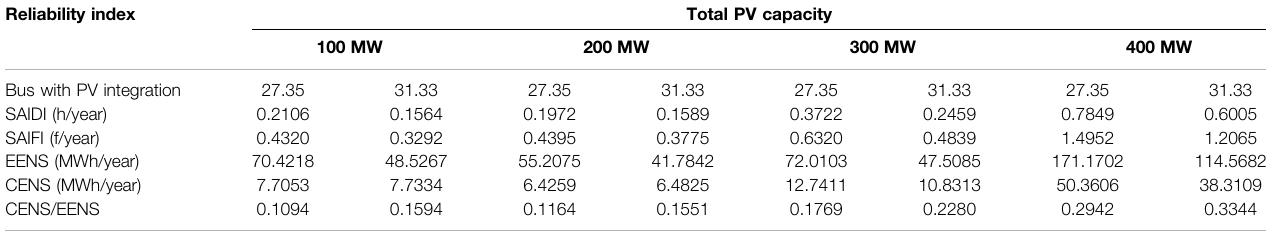
TABLE 5 | Reliability indexes with PV integration.